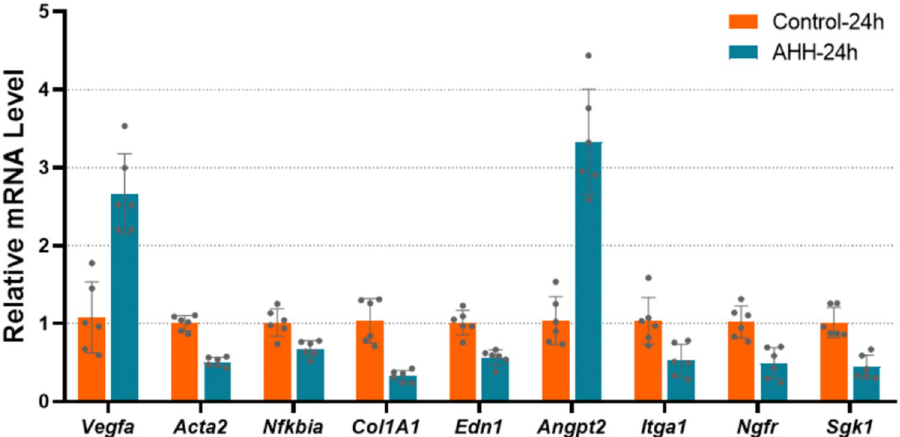
Figure 4. Reverse transcription-quantitative polymerase chain reaction analysis results of nine core differentially expressed genes (DEGs) screened via the protein–protein interaction network. The bars represent geometric means ± standard deviations. mRNA levels of these genes differed between the ground-level control and acute hypobaric hypoxia experimental groups ( p < 0.05,